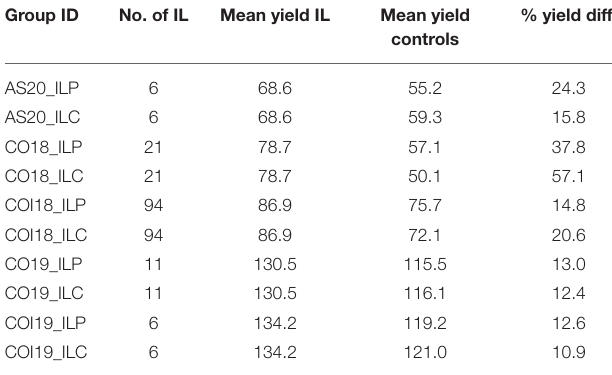
TABLE 2 | Percentage of mean yield difference between top-performing ILs and controls (parents and checks) per treatment in each year and